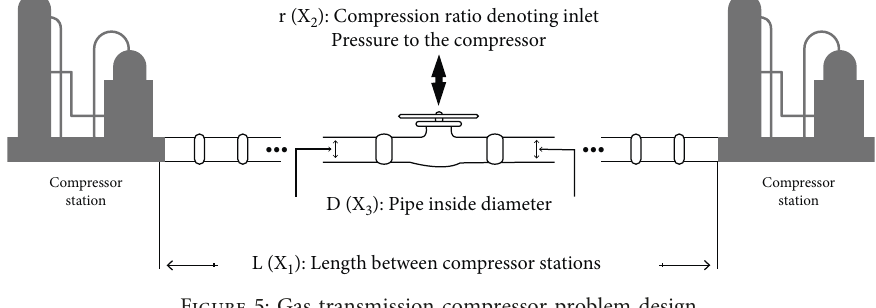
Figure 5: Gas transmission compressor problem design.